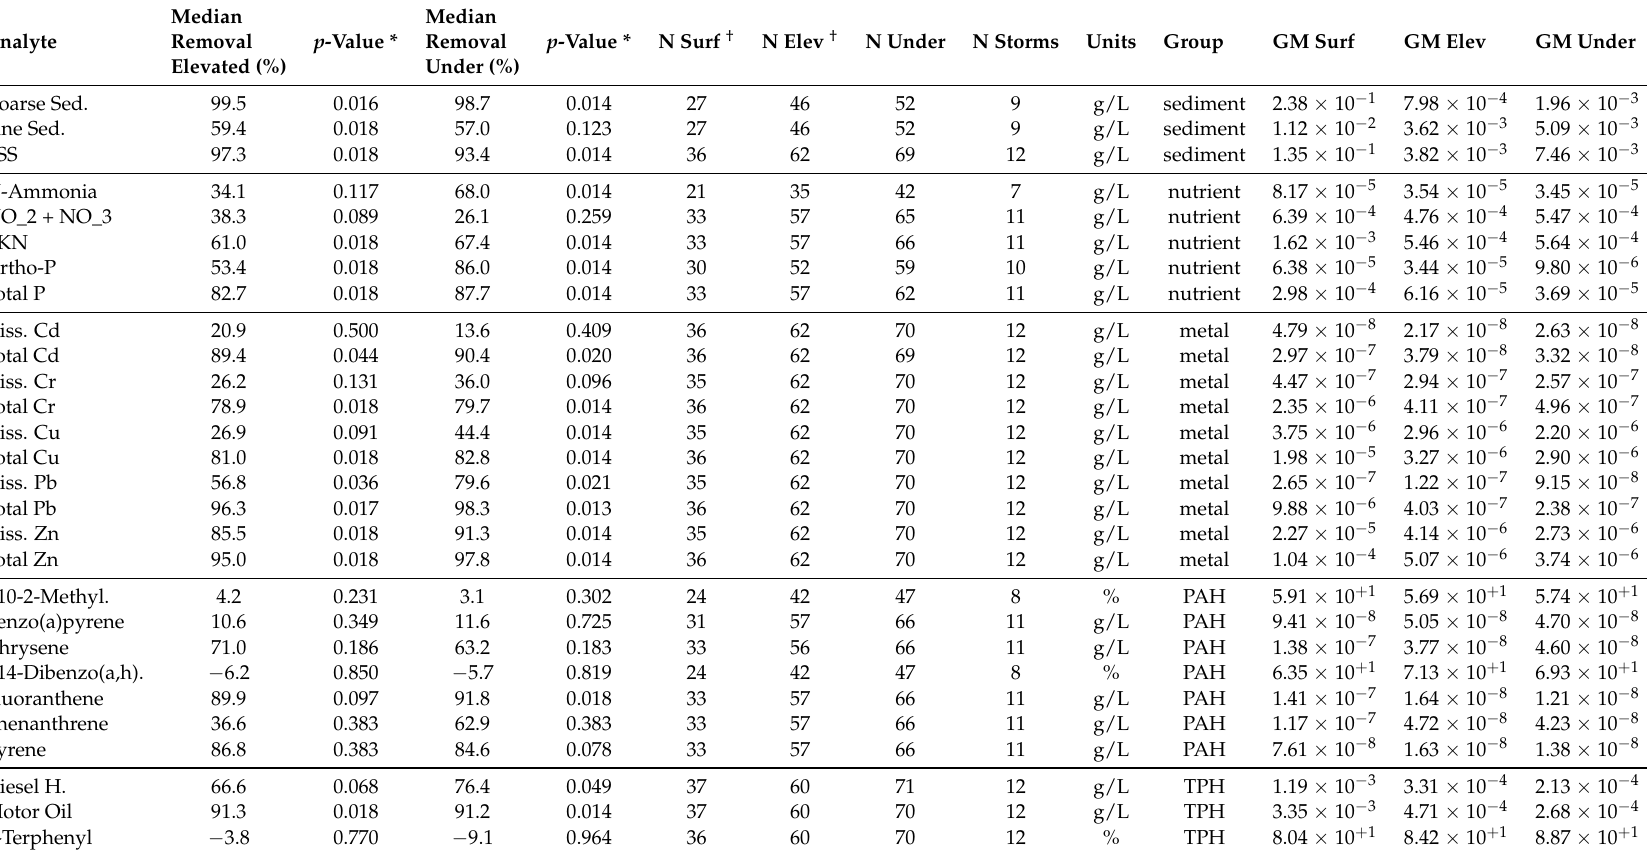
Table 2. Removal efficiencies of sediments by porous asphalt. Removal efficiencies calculated on a per storm basis, with median removal efficiency at two drain positions reported below. Samples were collected at three drain positions, surface (IA cells only), elevated , and under (PA cells only). Geometric Means (GM) reported in this table were calculated using pooled values across all